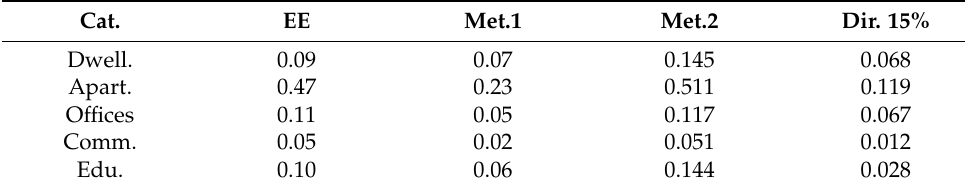
Table 14. Energy consumption reduction in 2033 vs. 2020 for EPBD and LTRS (%). Cat. EE Met.1 Met.2 Dir. Dwell. Apart. Comm.